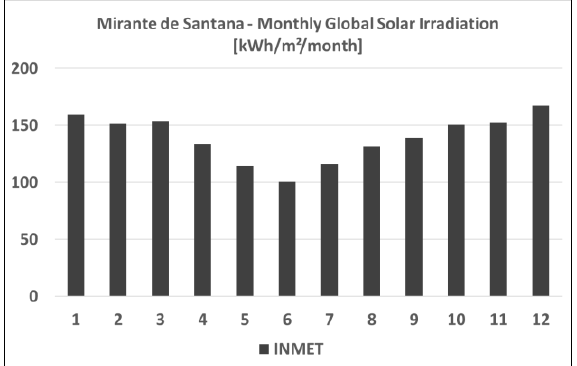
Figure 6. Average monthly irradiation values from the weather station “São Paulo Mirante” (Data source: